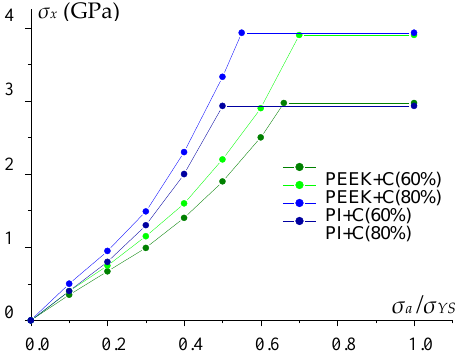
Figure 15. Change in tensile strength ( σ x ) under load along the x -axis (along CF) vs. peel stresses for the PEEK and PI-based composites with the 60/40 and 80/20 vol. % ratios.